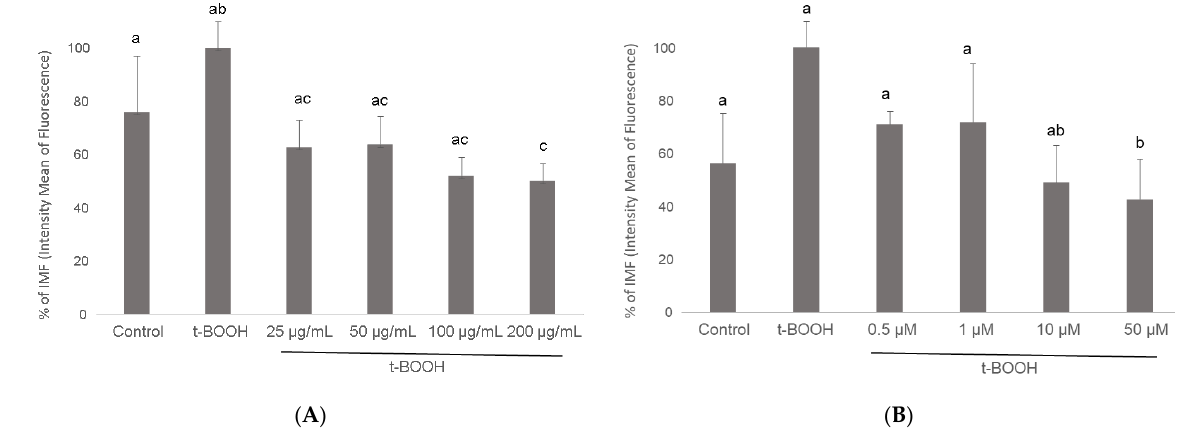
Figure 4. Effect of pre-treatment of differentiated SH-SY5Y cells with cocoa extract ( A ) and EC ( B ) prior to oxidative stress on ROS generation determined by flow cytometry. Values are means ± SD, n = 8. Values are expressed as a percent relative to the control condition. Different letters indicate statistically significant differences ( p < 0.05) among groups.